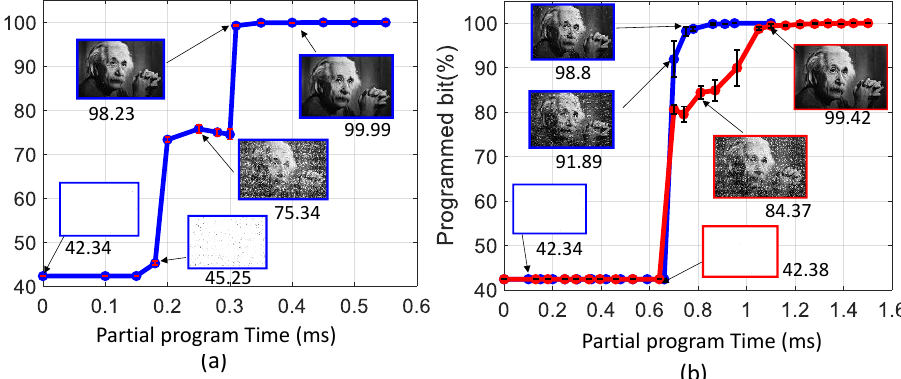
Figure 14. Percentage of programmed bits as a function of partial-page program time for the image data on ( a ) SLC, ( b ) LSB (blue), and MSB (red) pages.